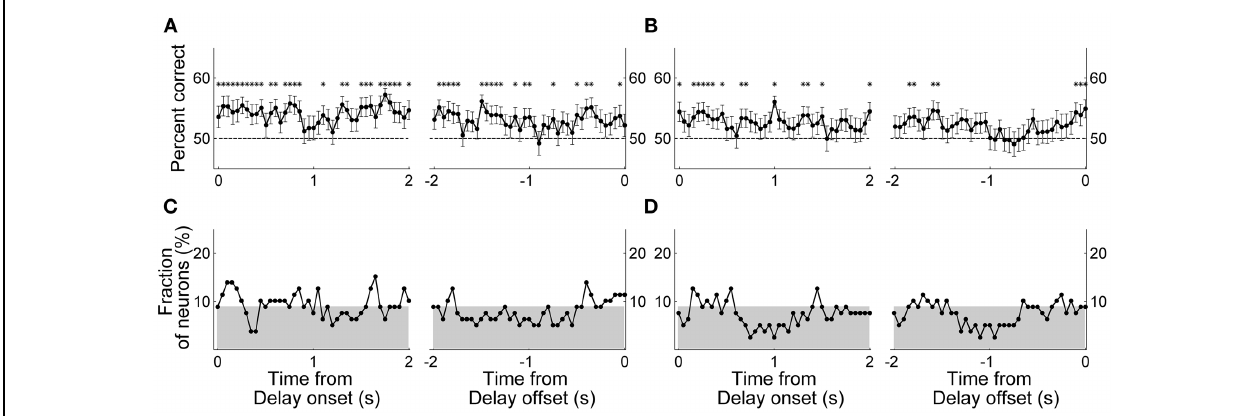
FIGURE 6 | Neural decoding of the animal’s goal choice. The animal’s trial-by-trial goal choices ( A and C , previous goal choice; B and D , upcoming goal choice) were predicted using a discriminant analysis based on individual neuronal activity during a 1-s time window that was advanced in 50-ms steps. In each panel, the first data point of the left graph (time from delay onset) corresponds to the first 1s of the delay period, and the last data point of the